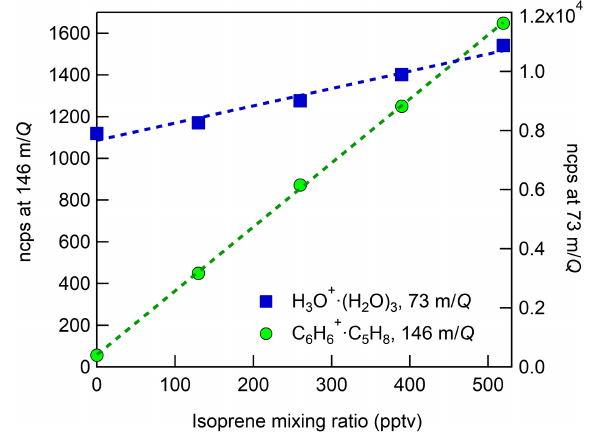
Figure 7. CI-ToFMS sensitivity to isoprene, observed as the isoprene–benzene cluster (green circles, C 6 H + and water protonated tetramer (blue squares, H 3 O + · (H 2 O ) 3 , 73 m/Q ). Dashed lines are the least square best-fit lines ( R 2 >0.98). Calibration was performed at SH of 14gkg − 1 in zero air.